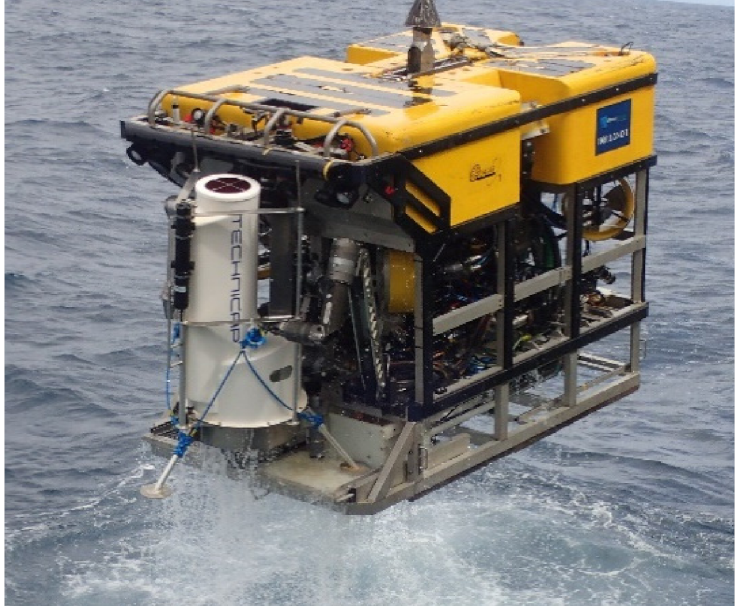
Figure 2. The Holland I ROV recovering a Little MonSta after successful deployment. Note the ROV 7 function manipulator arms clamping the lander to the ROV whilst resting on the ROV chassis. As a fail-safe, the lander is also hooked to the